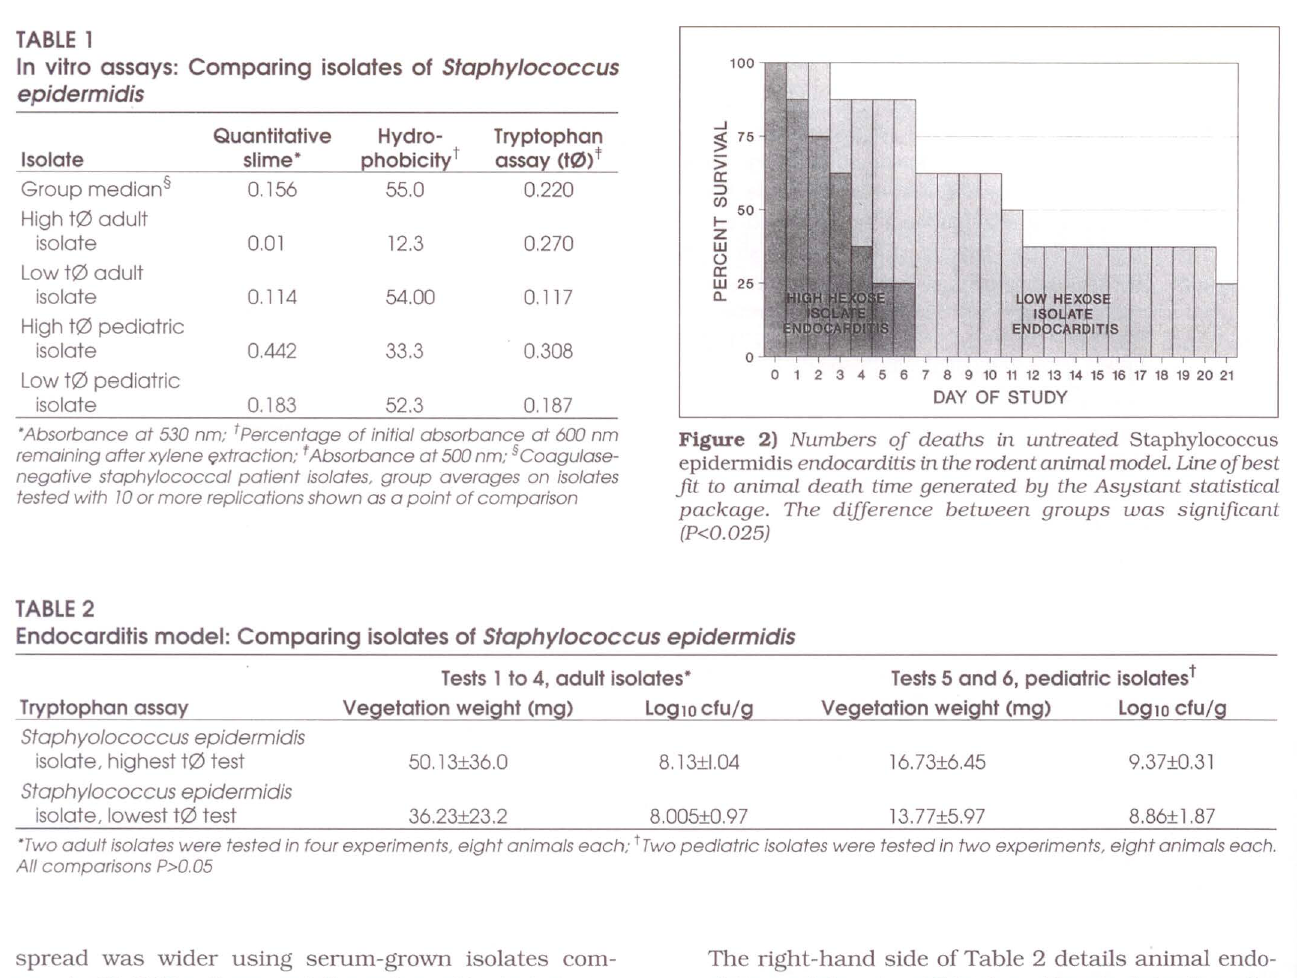
The right-hand side of Table 2 details animal